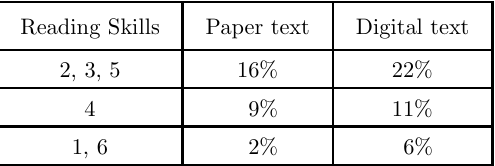
Reading Skills and Comprehension Outcomes Ranking Based on a “Failure” Criterion Reading Skills Paper